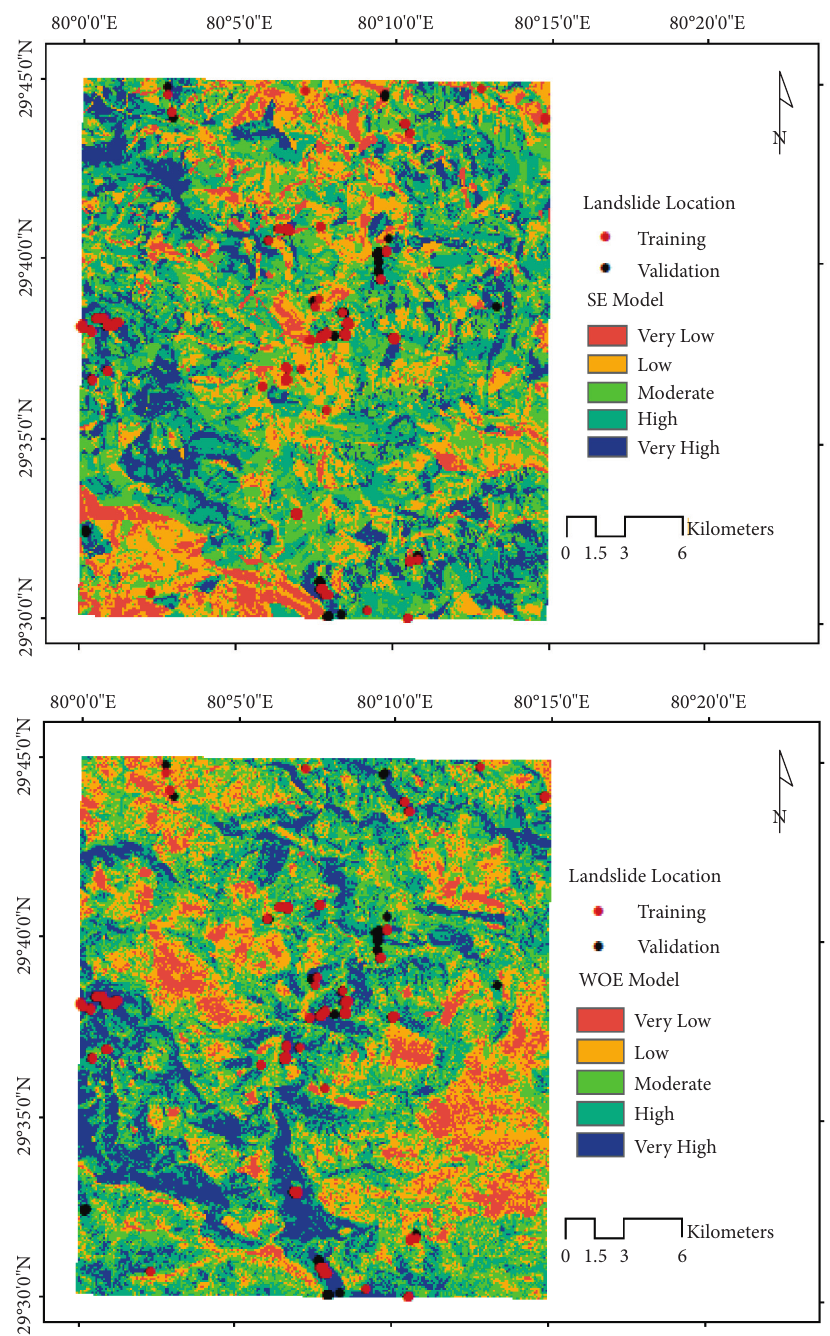
Figure 5: Landslide susceptibility map using SE model and WOE